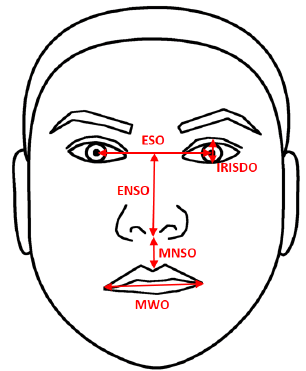
Figure 4. Measurements that define Facial Animation Parameter Units (FAPUs) based on the work in [28].